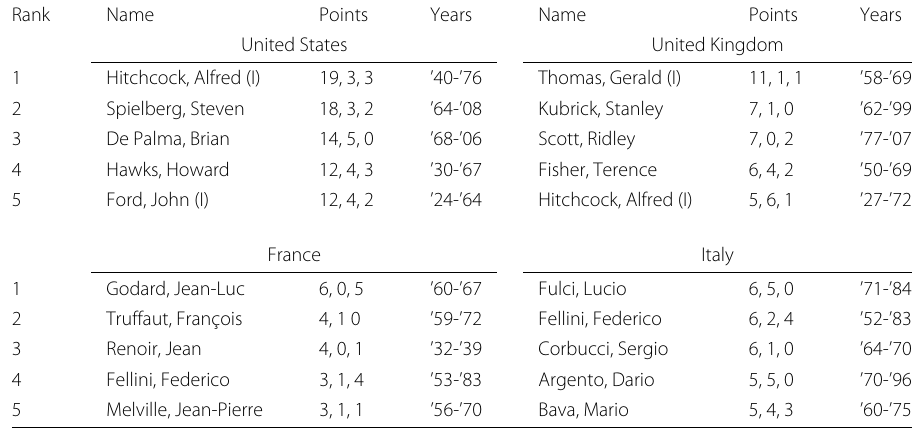
Table 7 Top 5 directors by country, for movies produced in the United States, the United Kingdom, France and